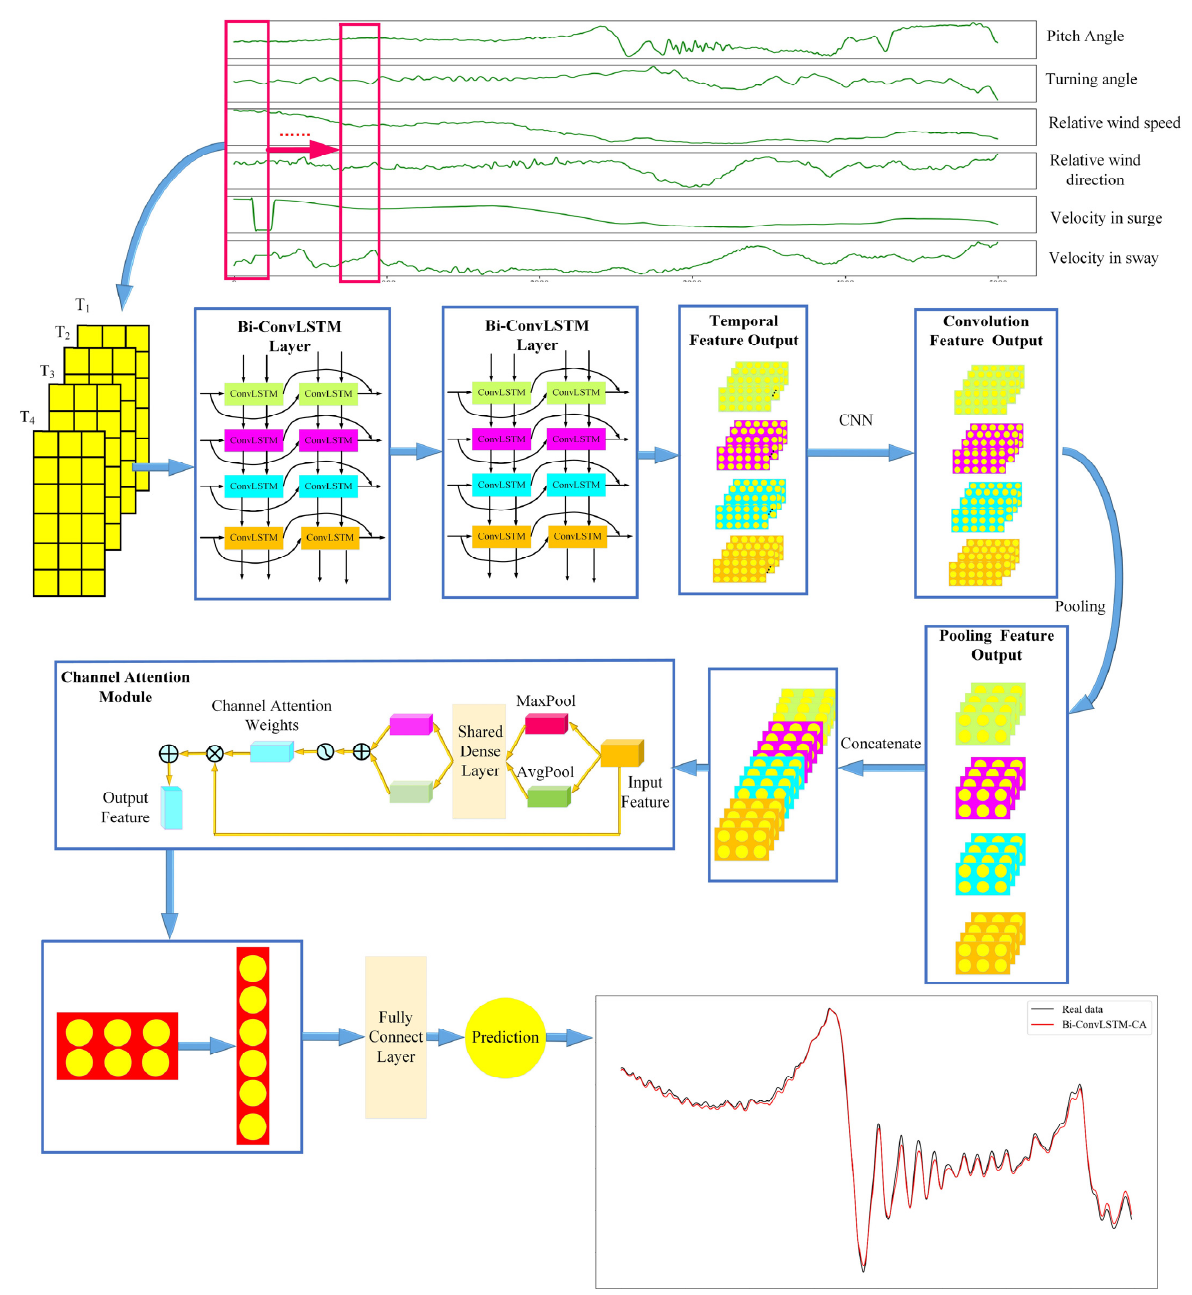
Figure 8. Ship pitch angle prediction based on Bi-ConvLSTM-CA model.